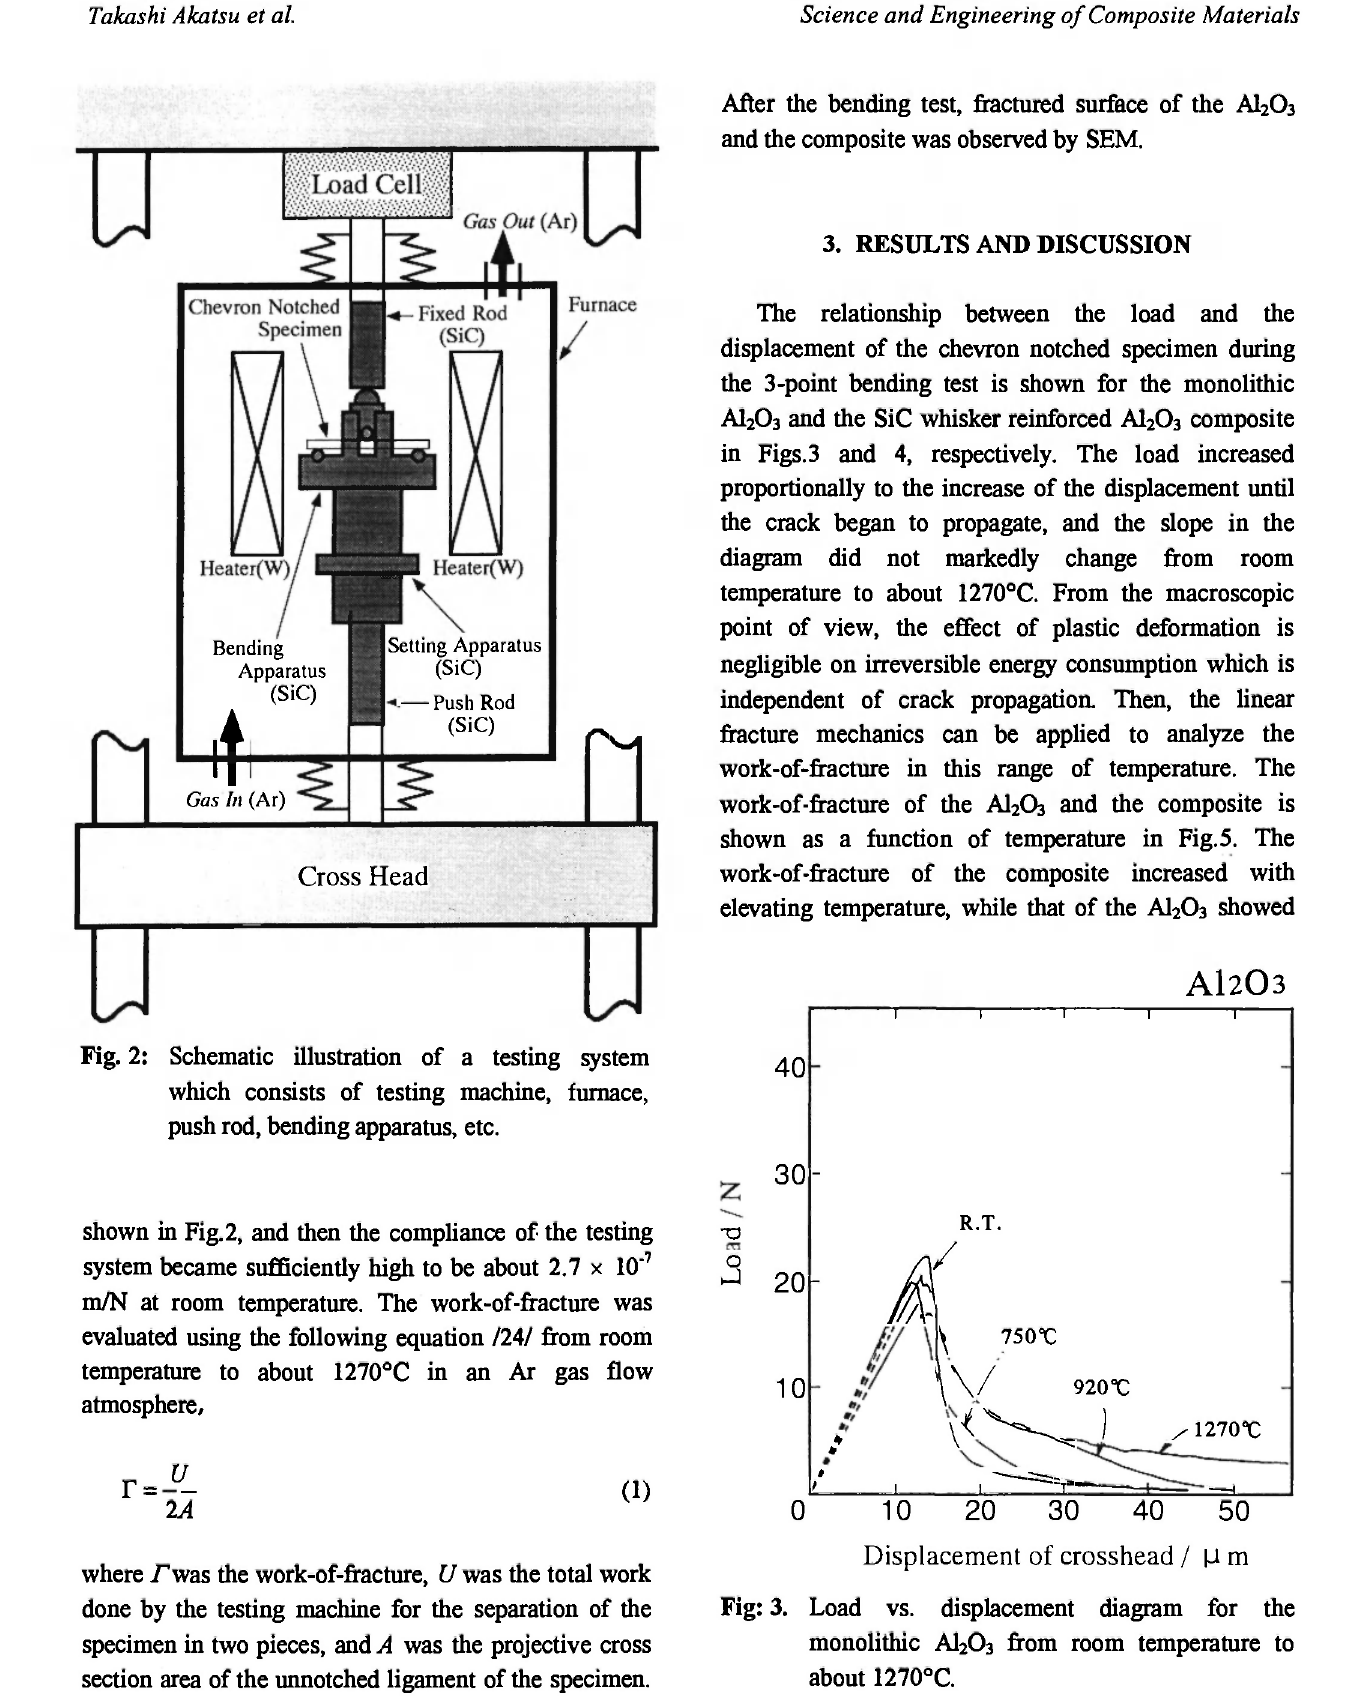
Fig: 3. Load vs. for the monolithic AI2O3 from room temperature to about